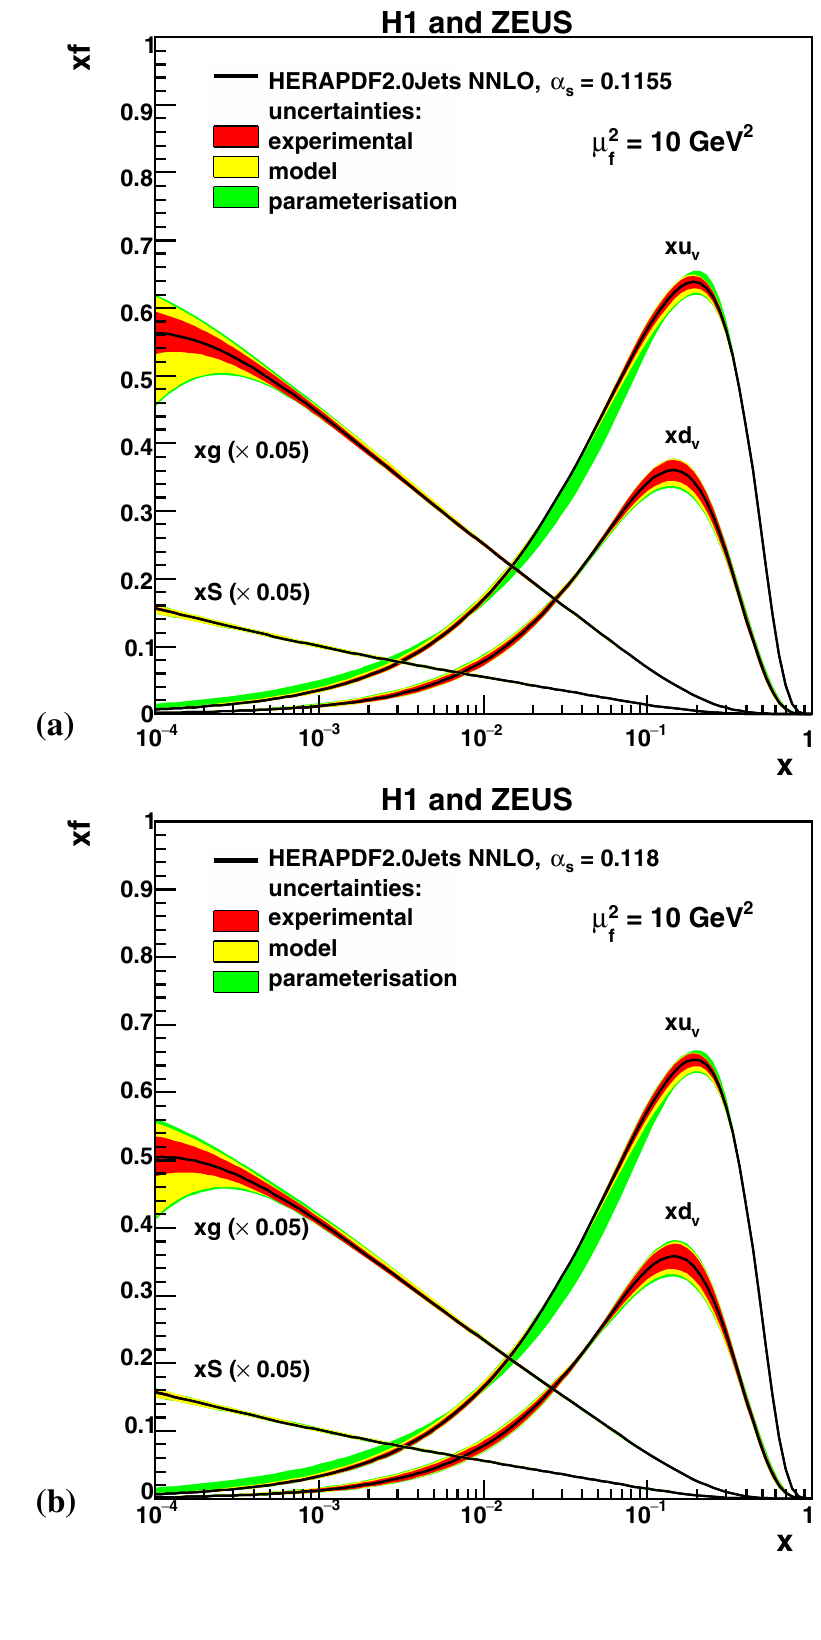
Fig. 4 The parton distribution functions xu v , xd v , xg and xS = x ( ¯ U + ¯ D ) of HERAPDF2.0Jets NNLO, with ) fixed to 0.1155 and b a α s ( M 2 Z ( M 2 ) fixed to 0.118, at the α s Z = 10GeV 2 . The scale μ 2 f uncertainties are shown as differently shaded